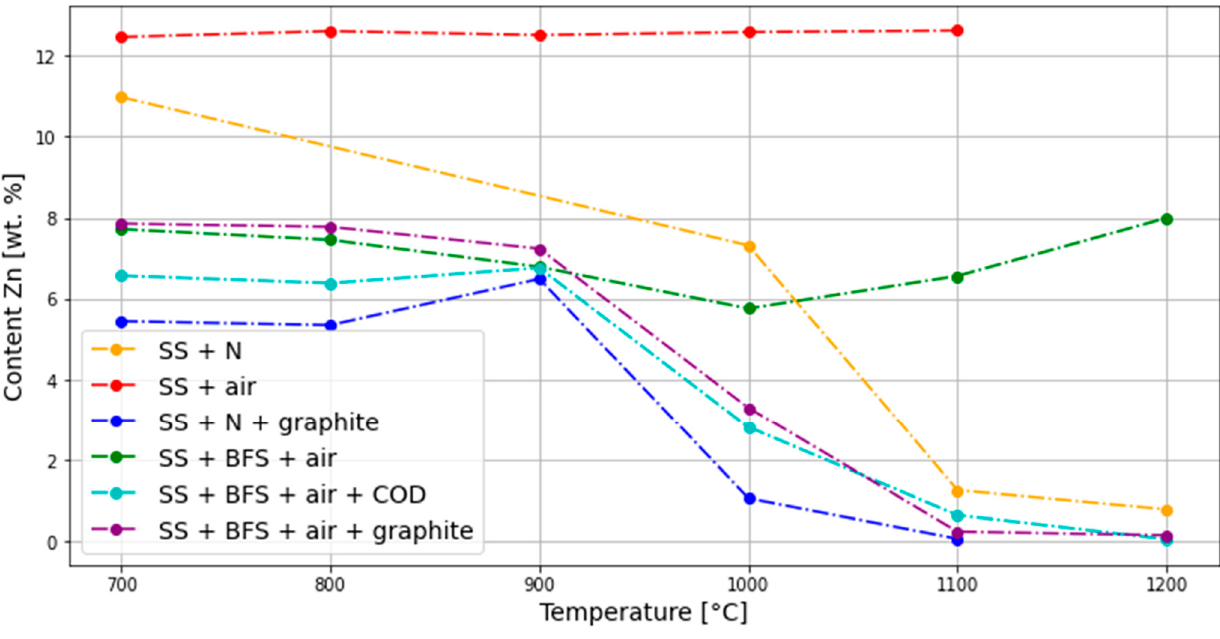
Figure 7. Effect of temperature, atmosphere and reducing element on Zn content in sludge. Table 4. The chemical composition of the experiments carried out for steelmaking sludge [wt.%] XRFS analysis.